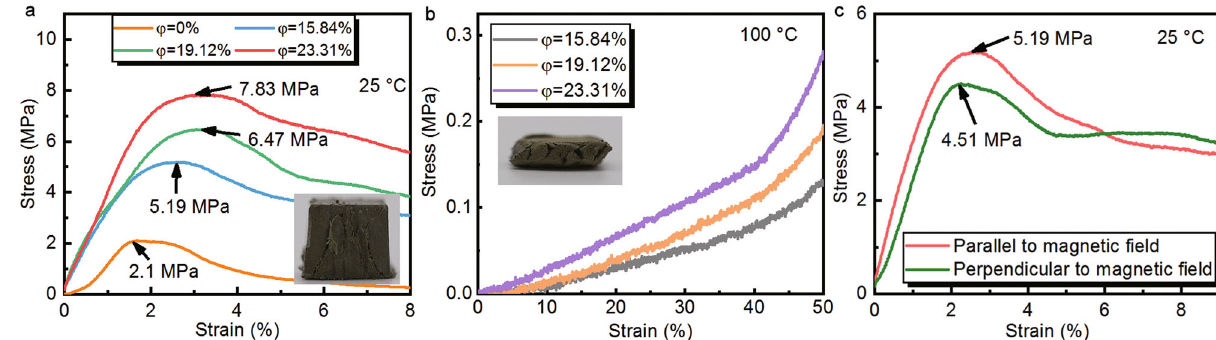
Fig. 4 Mechanical performance of magnetically tightened form-stable phase change materials (MTPCMs). a Compression stress-strain curves of pure paraf fi n and MTPCMs at the temperature below the melting point. b Compression stress-strain curves of MTPCMs at the temperature above the melting point. The insets are the typical compressed samples. Scale bars: 2 mm. c Anisotropic compression stress-strain curves of MTPCM at